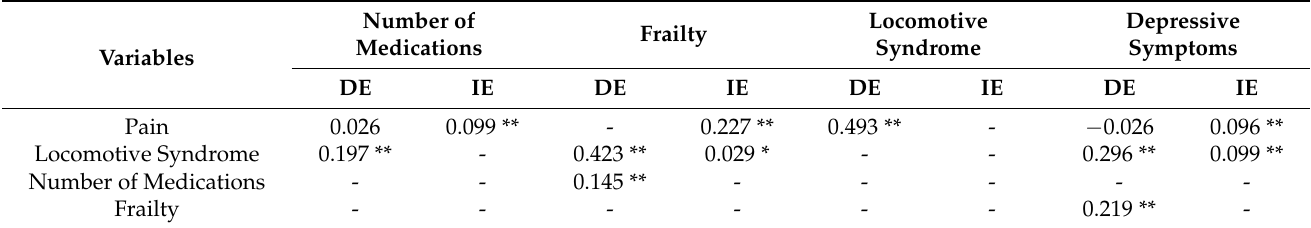
Figure 1. Path model of factors associated with depressive symptoms among older people. Overall model fit, χ 2 = 1.759, p = 0.6239, comparative fit index = 1.000, Tucker–Lewis index = 1.000, root mean squared error of approximation = 0.000, standardized root mean squared residual = 0.017. Significant at ** p < 0.01. Table 4. Standardized direct and indirect effects of exogenous and endogenous variables.